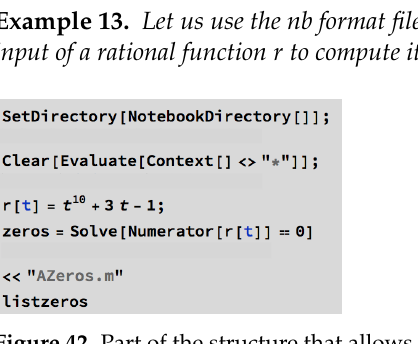
Figure 41. Output given by the [AZeros] and [APoles] algorithms.